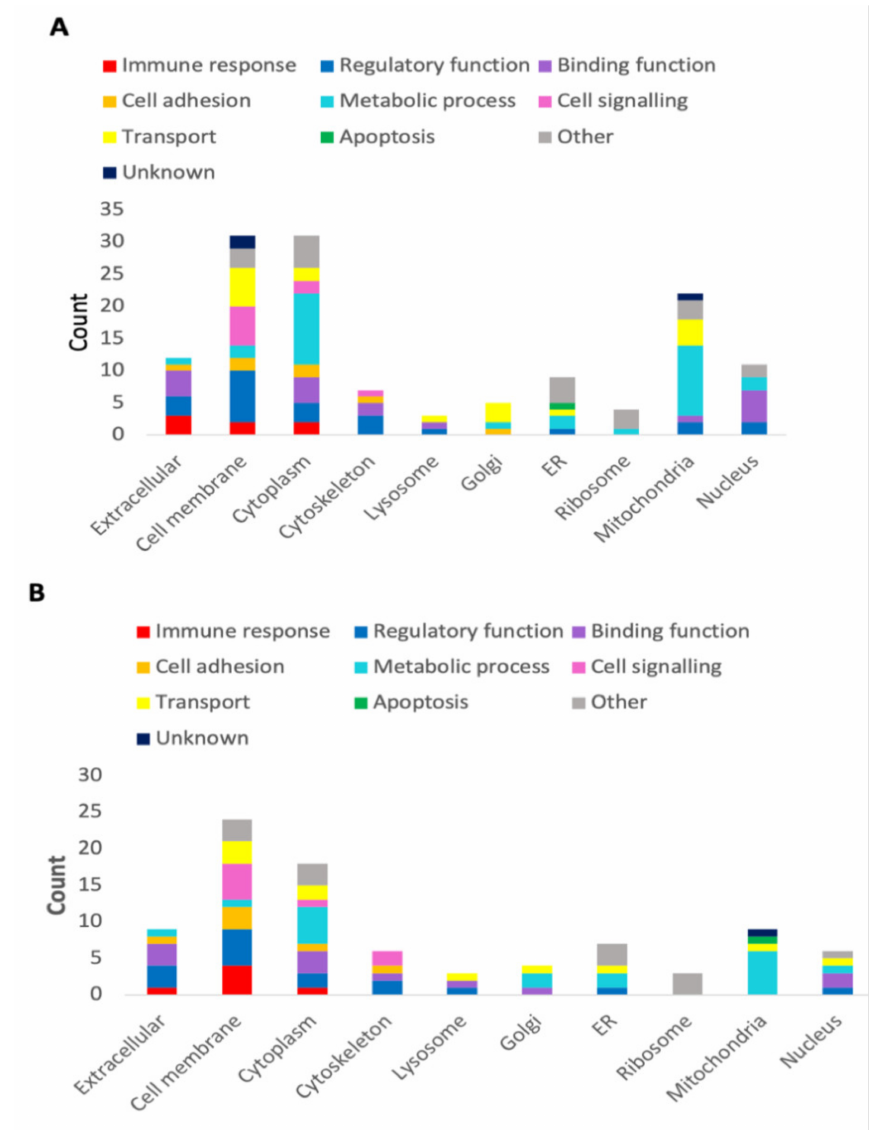
Figure 4. Characterisation of proteins in sheep abomasal tissue that interacted with Teladorsagia circumcincta galectin (Tci-gal-1). The profiles were categorised based on biological processes and cellular locations of Tci-gal-1-bound abomasal whole tissue ( A ) and Tci-gal-1-bound abomasal scrape tissue ( B